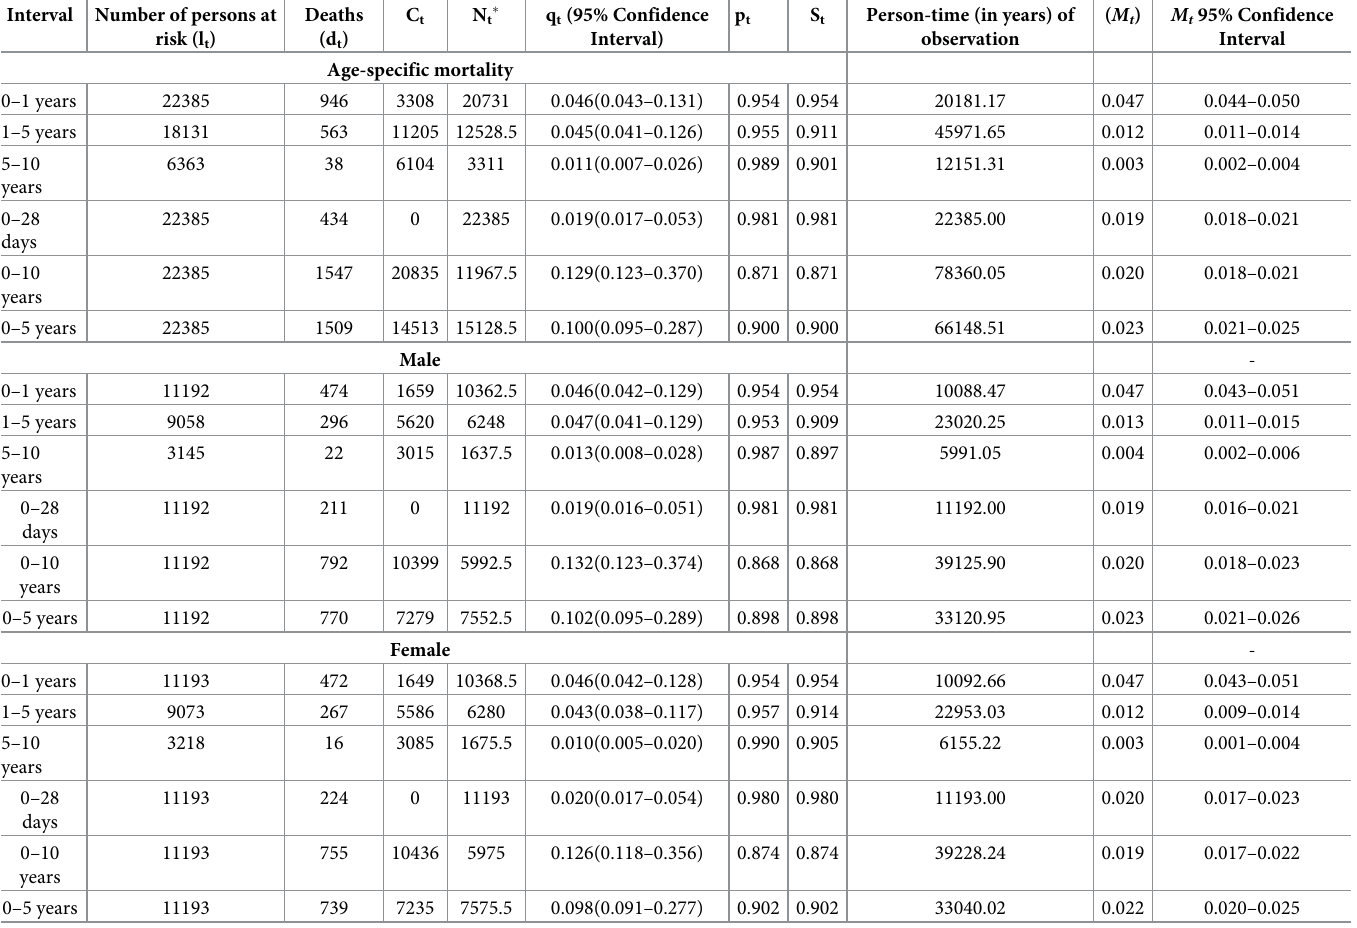
Table 2. Under 10 mortality estimated-abridged life table using 2005–2015 birth registration